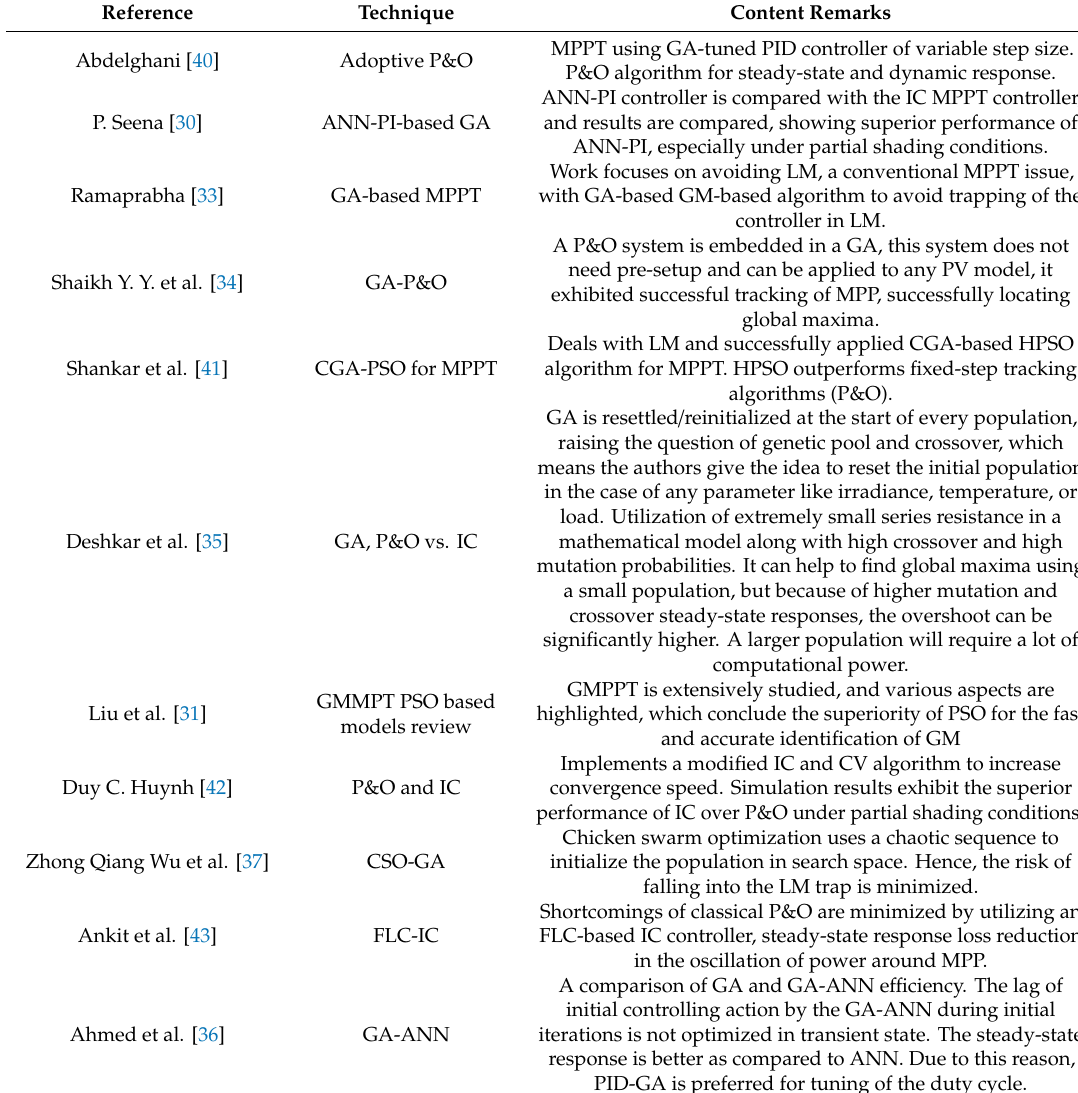
Table 2. Comparative